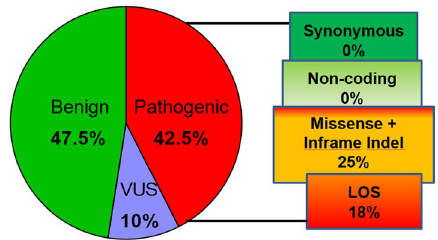
Fig. 6 Distribution of various types of mutations in PYCR2